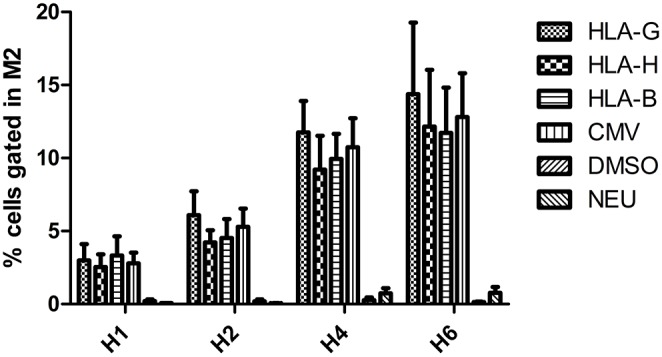
Percentage of PBMC overexpressing HLA-E compared with DMSO (defining M2) after 1, 2, 4, and 6 h of peptide incubation.